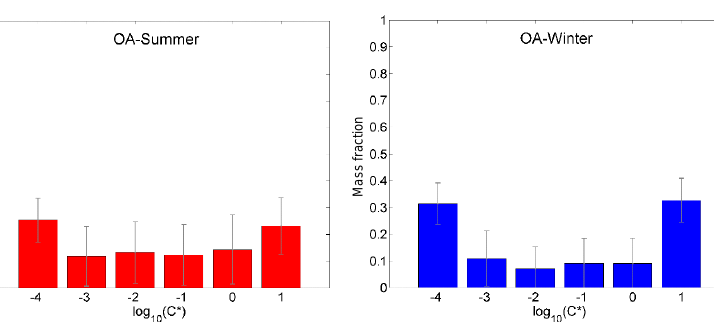
Figure 4. Estimated volatility distributions for summer (left panel) and winter total OA (right panel). The error bars correspond to the fitting uncertainties according to the algorithm of Karnezi et al.